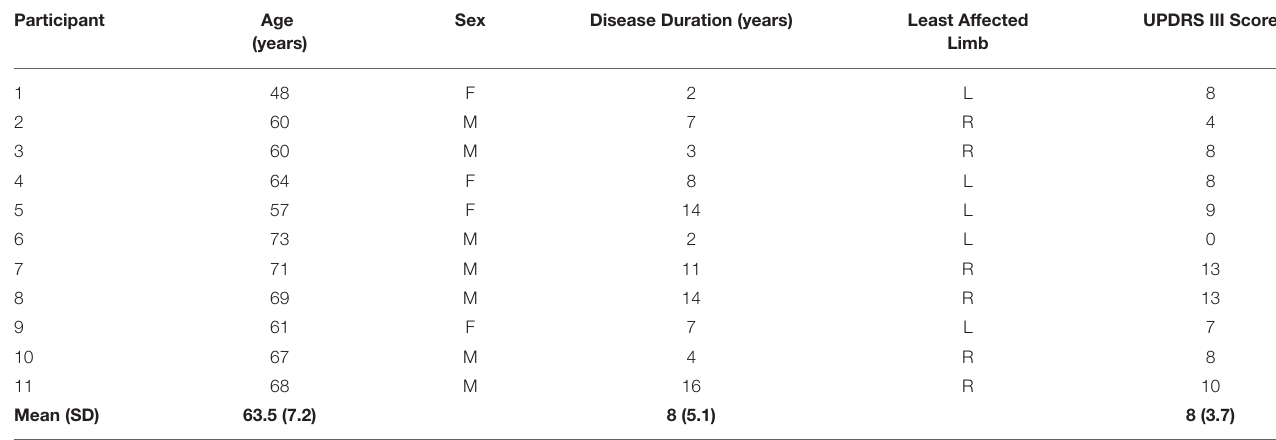
TABLE 1 | Participant characteristics, including age, sex, disease duration, the least-affected limb, and Unified Parkinson’s Disease Rating Scale (UPDRS) motor subsection (III) score. Participant Age Sex Disease Duration (years)